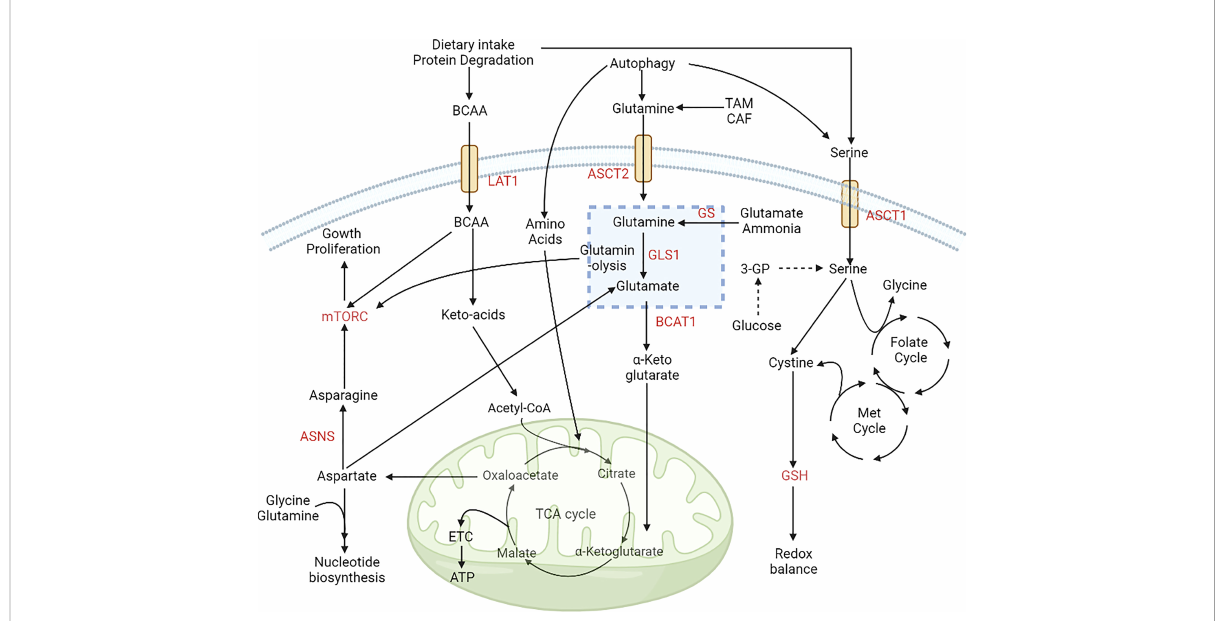
FIGURE 3 Alterations in amino acid metabolism during cancer progression. Amino acids are used by cancer cells as a source of carbon and nitrogen. The expression of ASCT2 increases glutamine uptake, and it is converted to glutamate via glutaminase and provides a TCA-cycle intermediate for energy production. Intake of BCAAs is also upregulated by the expression of LAT1. The folate methionine cycle is fuelled by serine, which helps maintain redox balance in the microenvironment. These alterations aid the growth and proliferation of cancer cells via upregulation of the mTOR signaling pathway (98). [LAT1, Large amino acid transporter 1; ASCT2, Alanine serine cysteine transporter 2; BCAA, Branch chain amino acids; BCAT1, Branch chain aminotransferase 1; ASNS, Asparagine synthetase; ETC, Electron transport chain; GSH, Glutathione; Met, Methionine; 3PG, Glyceraldehyde 3